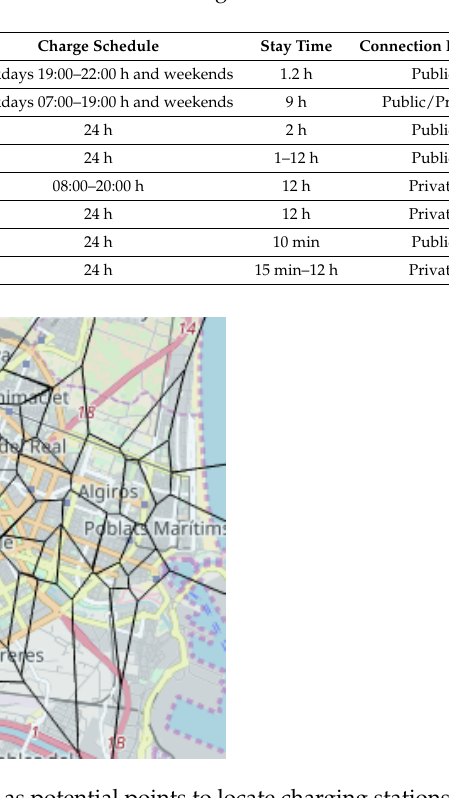
Table 2. Areas selected as potential points to locate EV charge stations.